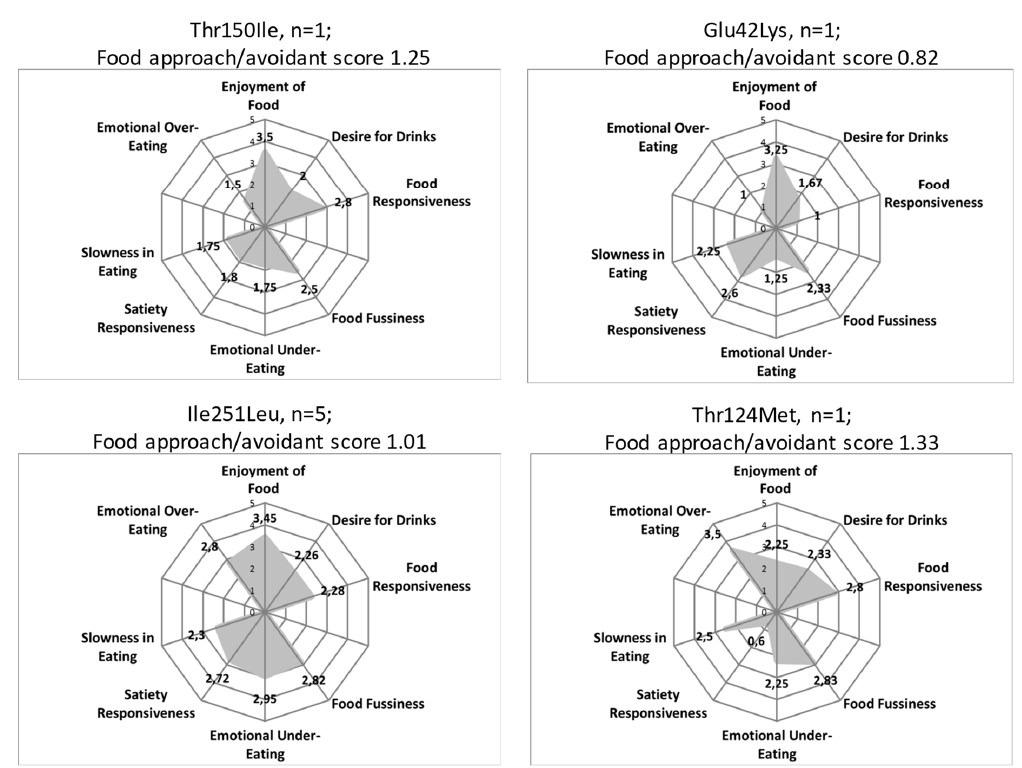
Figure 1. Childhood Eating Behavior Score (CEBQ) in Spanish children with abdominal obesity. The Food approach/avoidant score refers to the quotient between the sums of scores of the “food approach” subscales divided by the sum of the scores of the “food avoidant” subscales. Subjects with mutations in MC4R (Thr124Met, Thr150Ileu) and LCN2 (Thr124Met) genes were evaluated.